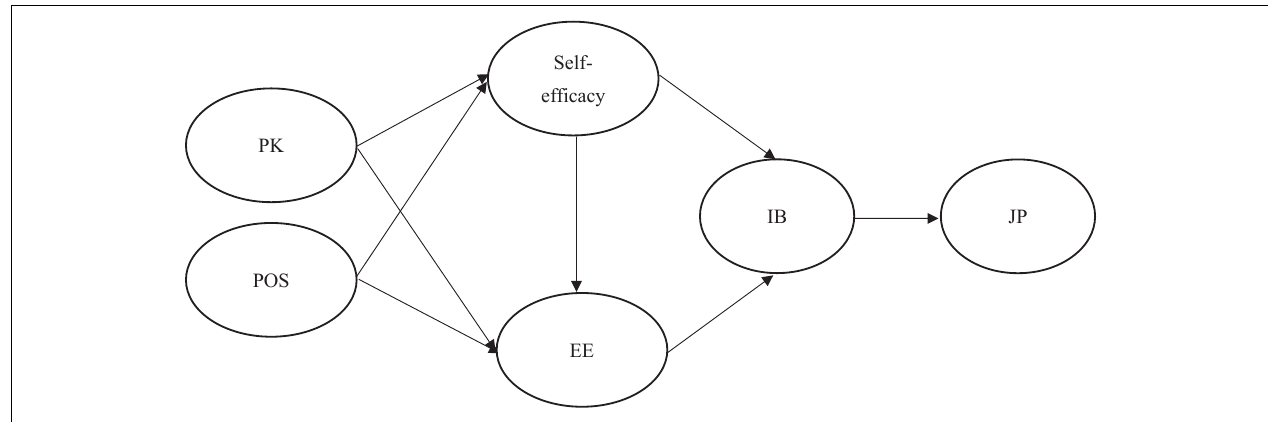
FIGURE 1 | Research framework. PK, prior knowledge; POS, perceived organizational support; EE, employee employability; IB, innovation behavior; JP, job performance.